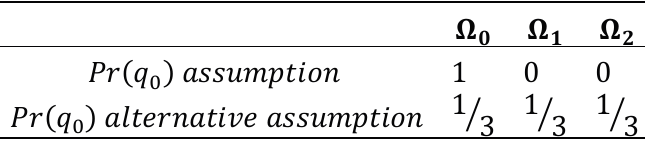
Table 1. State matrix probability